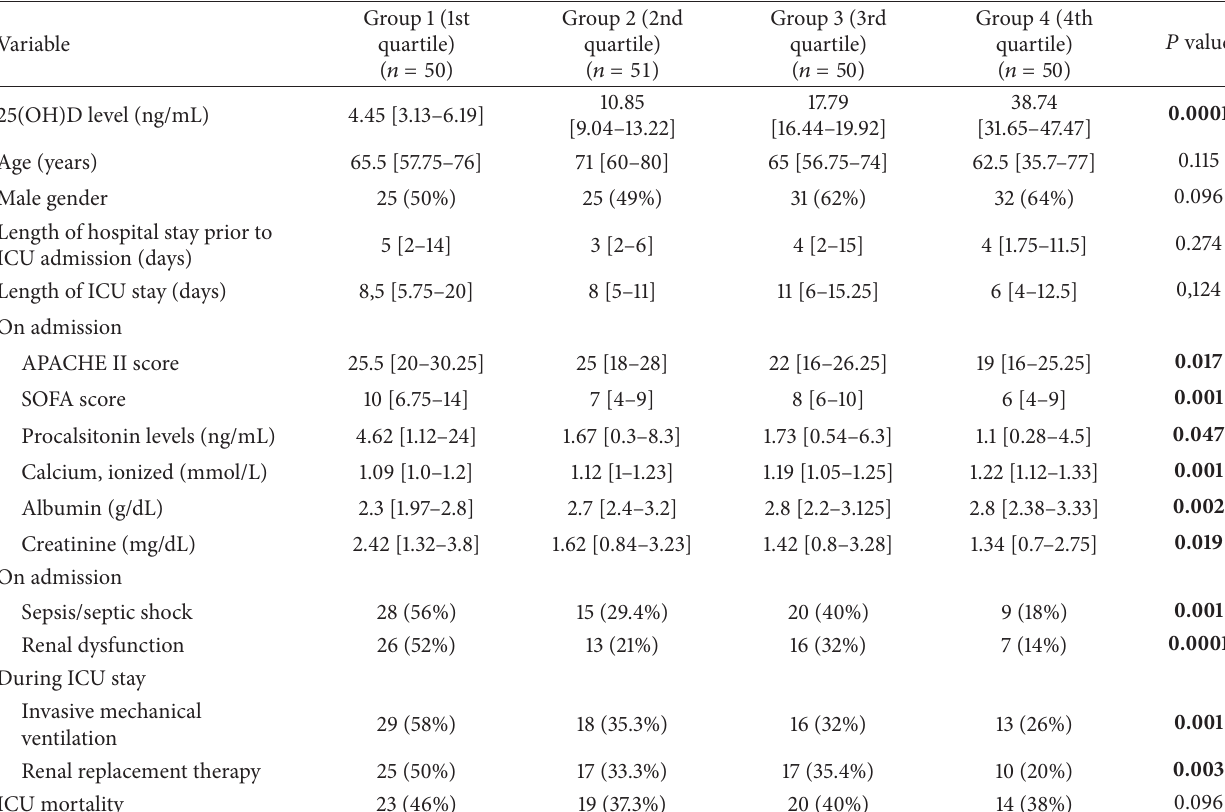
Table 3: Comparison of patients while separated four groups according to quartiles of admission vitamin D